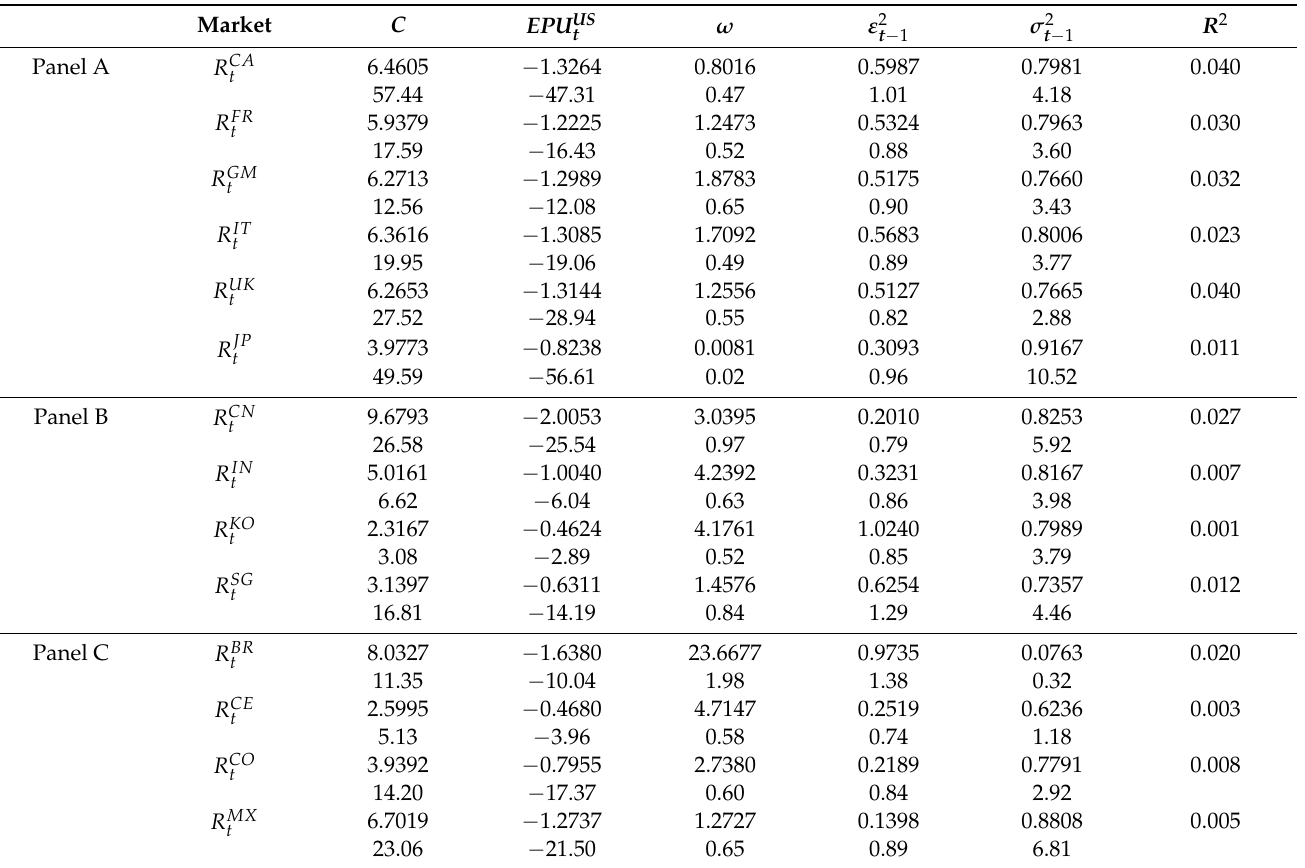
Table 2. Estimates of the global stock returns in response to U.S. economic policy uncertainty using the GED–GARCH procedure.